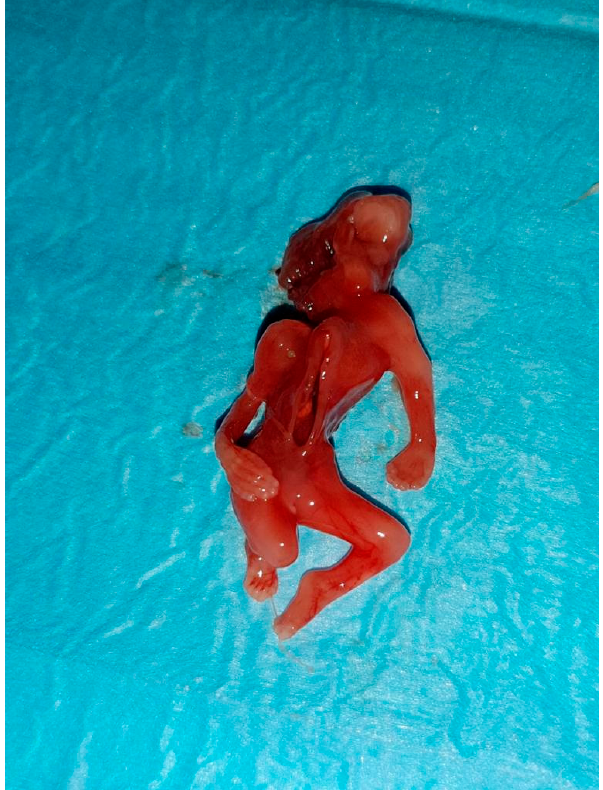
Figure 6. Macroscopic pathological examination of case report 2 at 13